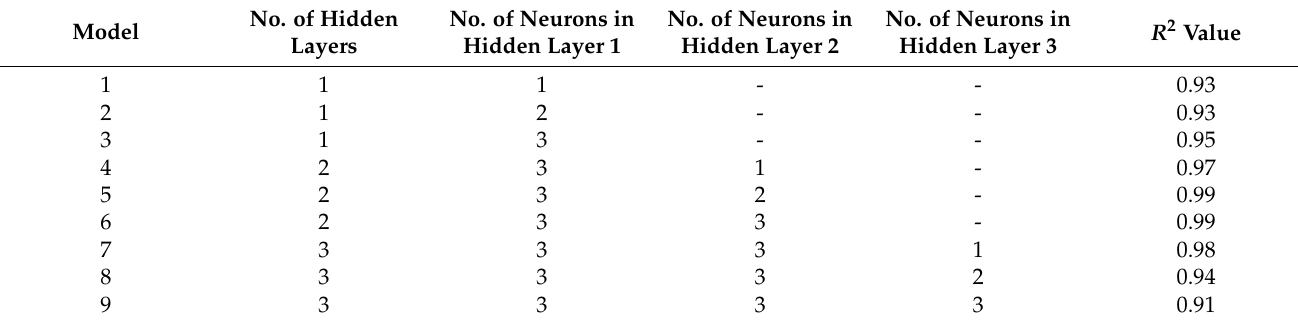
Table 6. Performances of the developed ANN models based on their coefficient of the determinant. Model